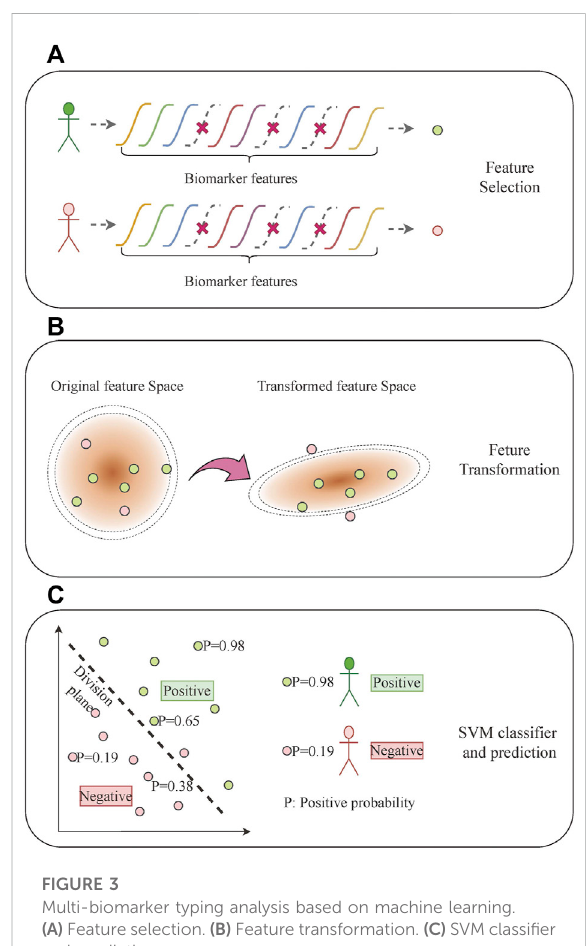
FIGURE 3 Multi-biomarker typing analysis based on machine